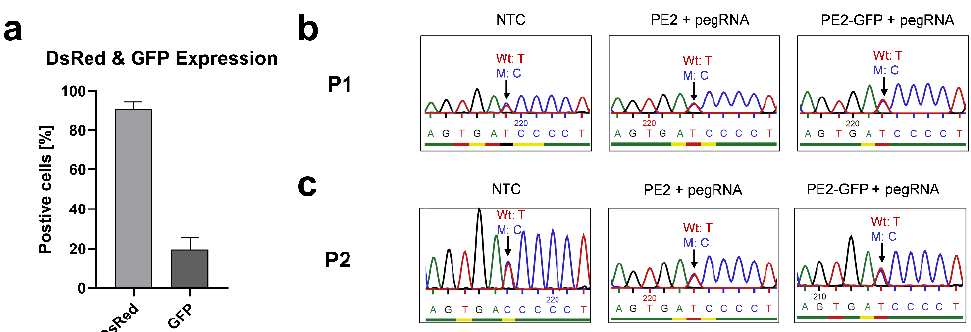
Figure 6. Prime editing in mosaic T cells to correct IL2RG c.458T>C mutation. PE (PE2/PE2-GFP mRNA) – pegRNA2 (carrying wild-type base c.458T of IL2RG ) was transfected to edit the